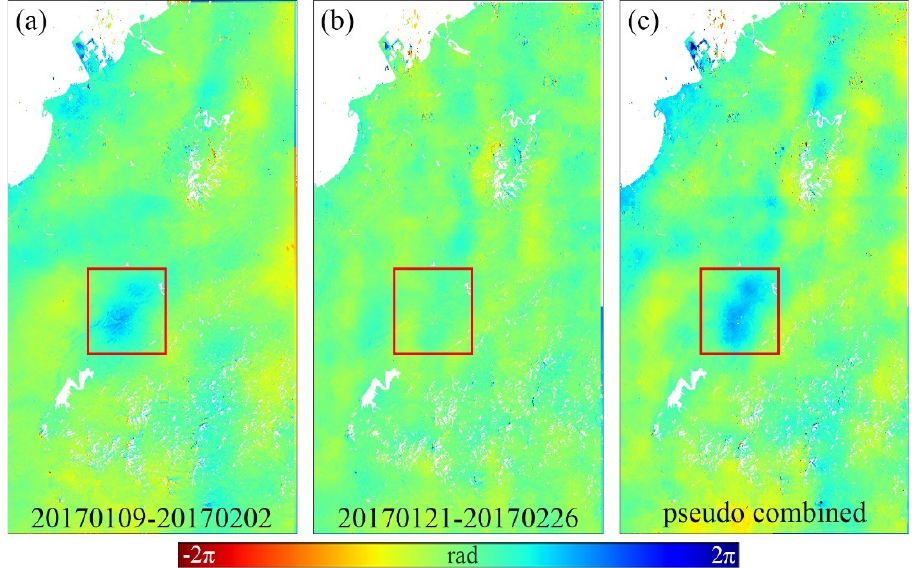
Figure 18. Example of the turbulence atmospheric effect. ( a , b ) The two original interferograms with different time spans; and ( c ) the pseudo-combined interferogram of the previous two images.